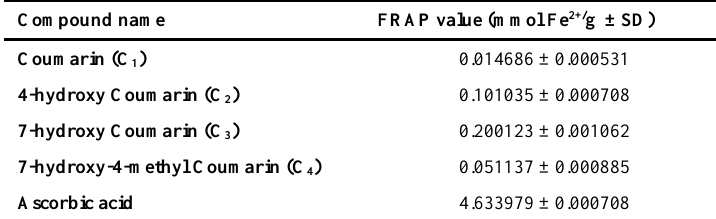
Table 2. FRAP value of tested coumarins, expressed in mean value ± SD